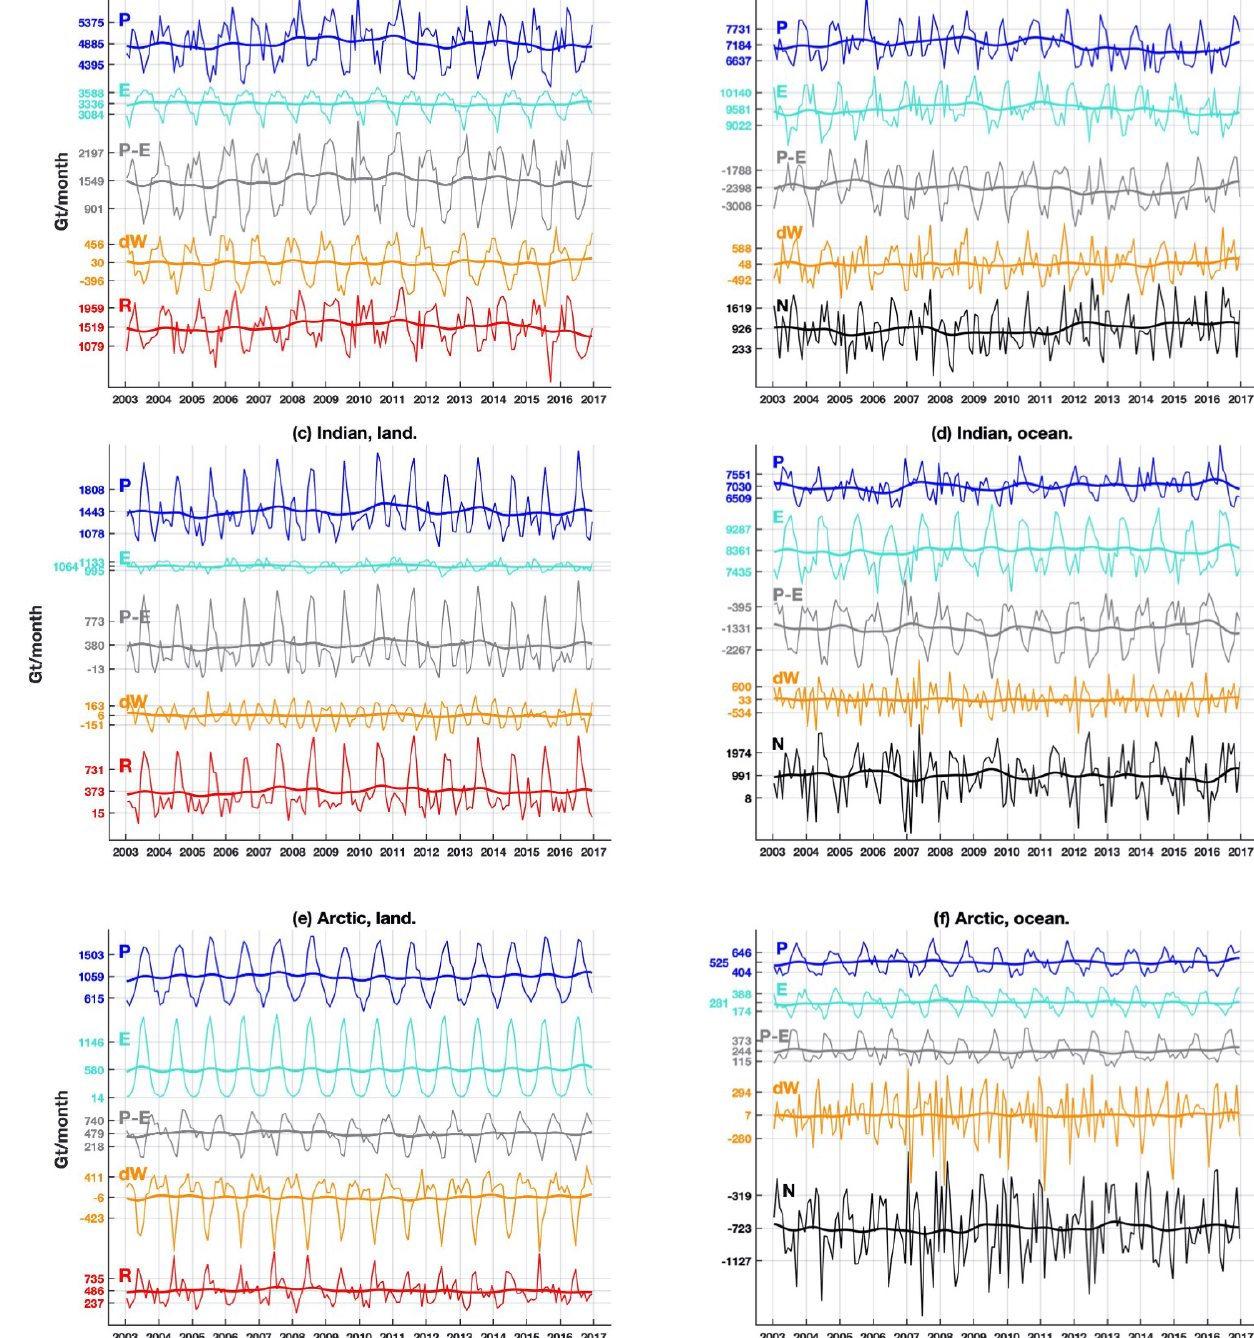
Figure 4. Same as Fig. 2 but for the Atlantic, Indian, and Arctic